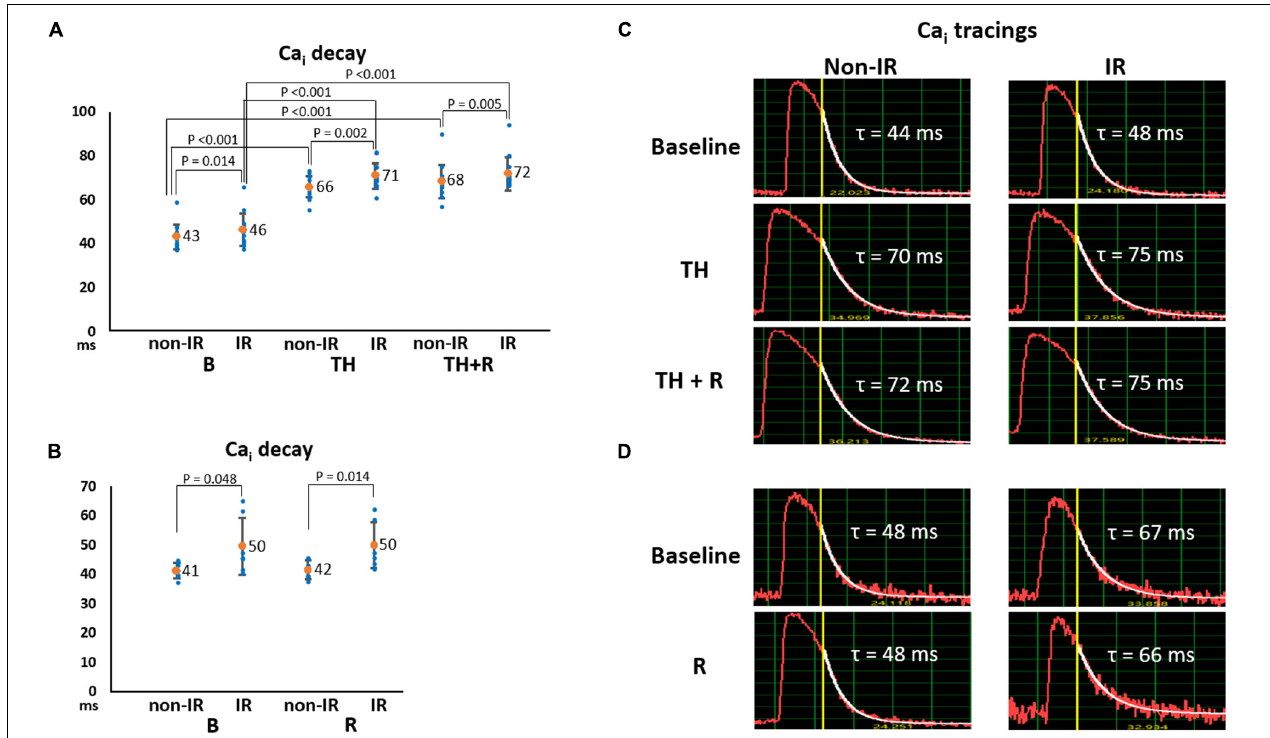
FIGURE 4 | Effects of therapeutic hypothermia (TH) and rotigaptide (R) on intracellular Ca 2 + (Ca i ) decay. (A,B) Summarized results of Ca i decay tau ( τ ) values between the ischemia–reperfusion (IR) and non-IR zones in the TH ( n = 14, repeated-measures ANOVA with post hoc LSD analysis) and non-TH groups ( n = 7, Student’s t -test), respectively. Numbers indicate the mean values. TH significantly increased the τ values in both non-IR and IR zones. Rotigaptide had no significant effects on Ca i decay. (C,D) Representative examples of Ca i decay in the non-IR and IR zones in the TH and non-TH groups,